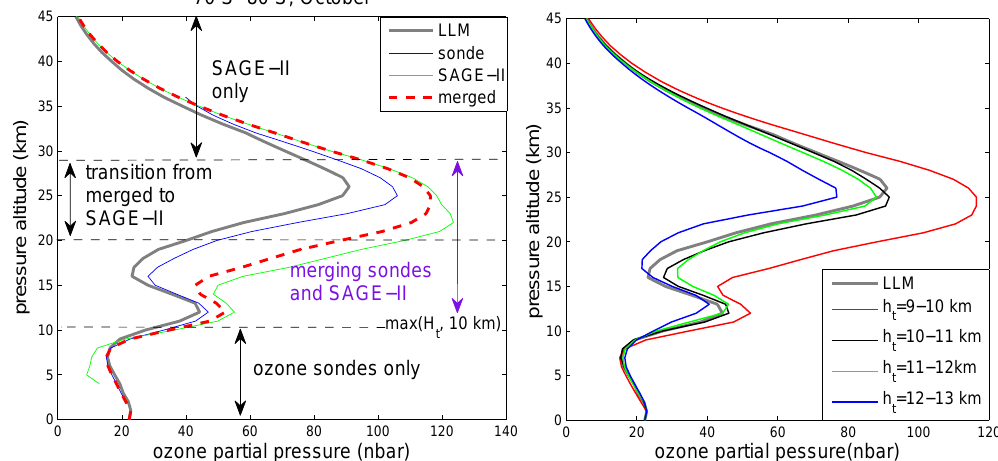
Fig. 6. Illustration of merging sonde and SAGE-II data based on data in October at 70–80 ◦ S. Left: illustration of merging for one of the tropopause heights, which is 9–10km; altitude ranges for merging sonde and SAGE-II data and for linear transition to SAGE-II data are highlighted. In this example, N so =90 and N SA =160. LLM profile is presented for comparison. Right: merged climatological profiles for different tropopause heights and the LLM profiles for this latitude bin.